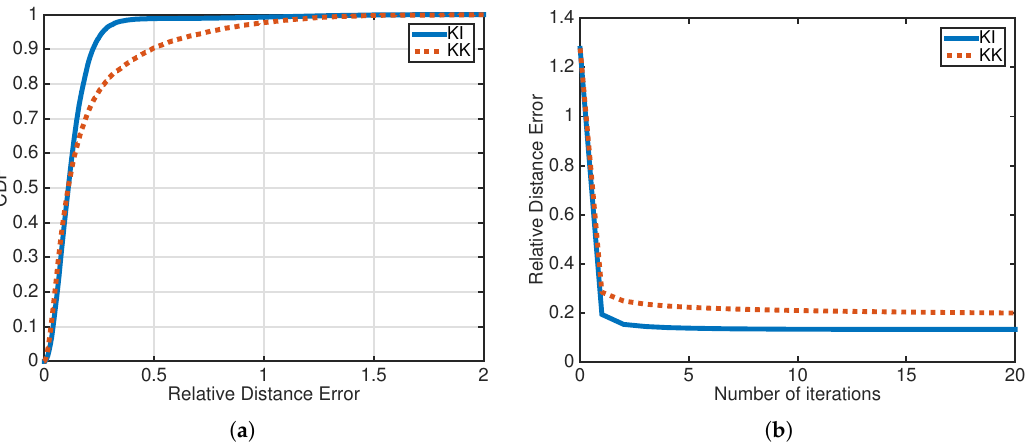
Figure 5. ( a ) CDF of relative localization error for KI and KK in dense networks. ( b ) Relative localization error as a function of the number of iterations for KI and KK in dense